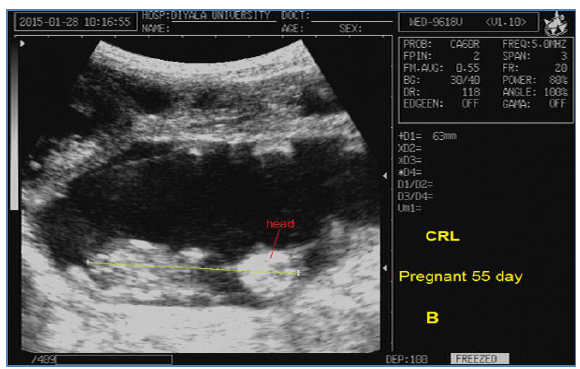
Figure, 2: Measurement of fetal CRL in 8 th week of pregnancy, indicated by straight line (Sector probe 5MHz).